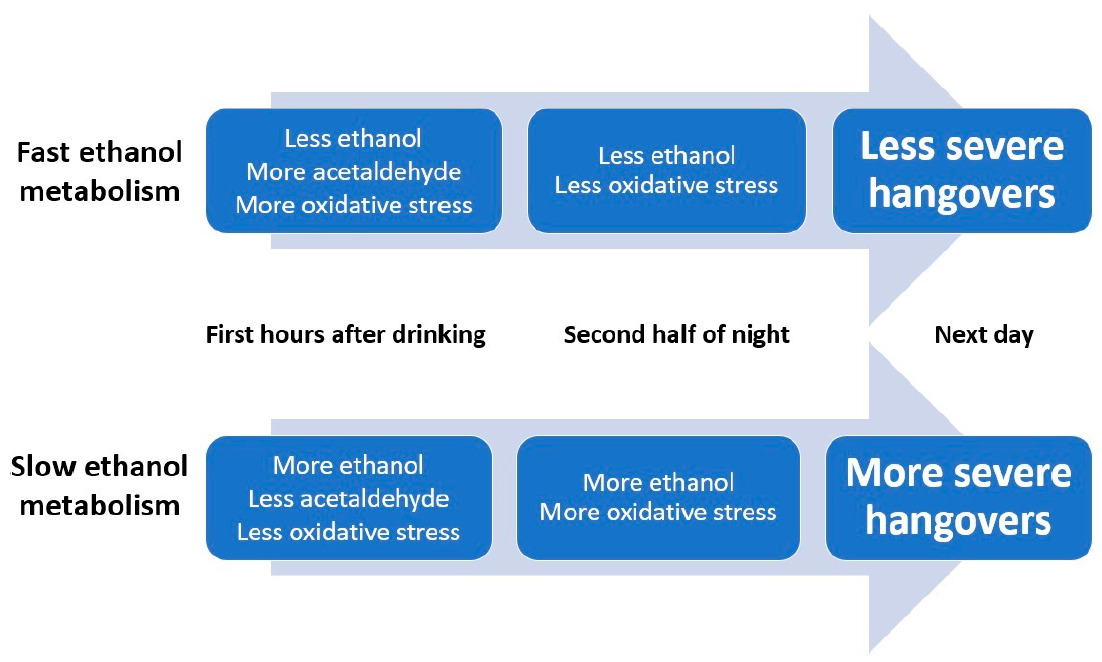
Figure 5. Schematic representation of the hypothesized relationship between alcohol metabolism and hangover severity.